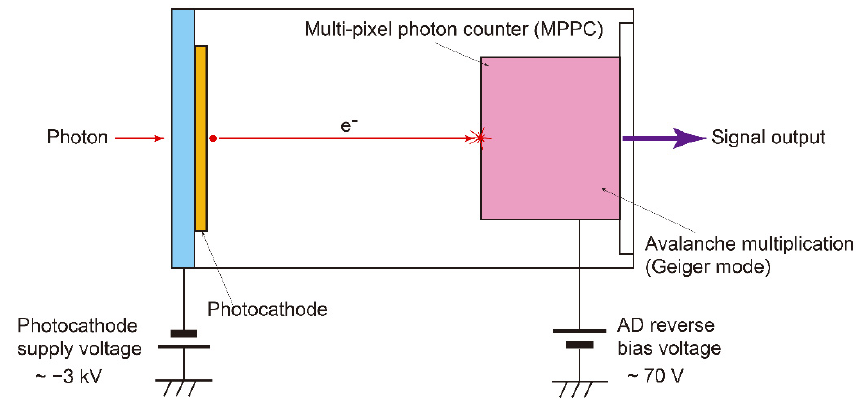
Figure 14. Schematic of multi-pixel photon counters (MPPC)-incorporated HPD.